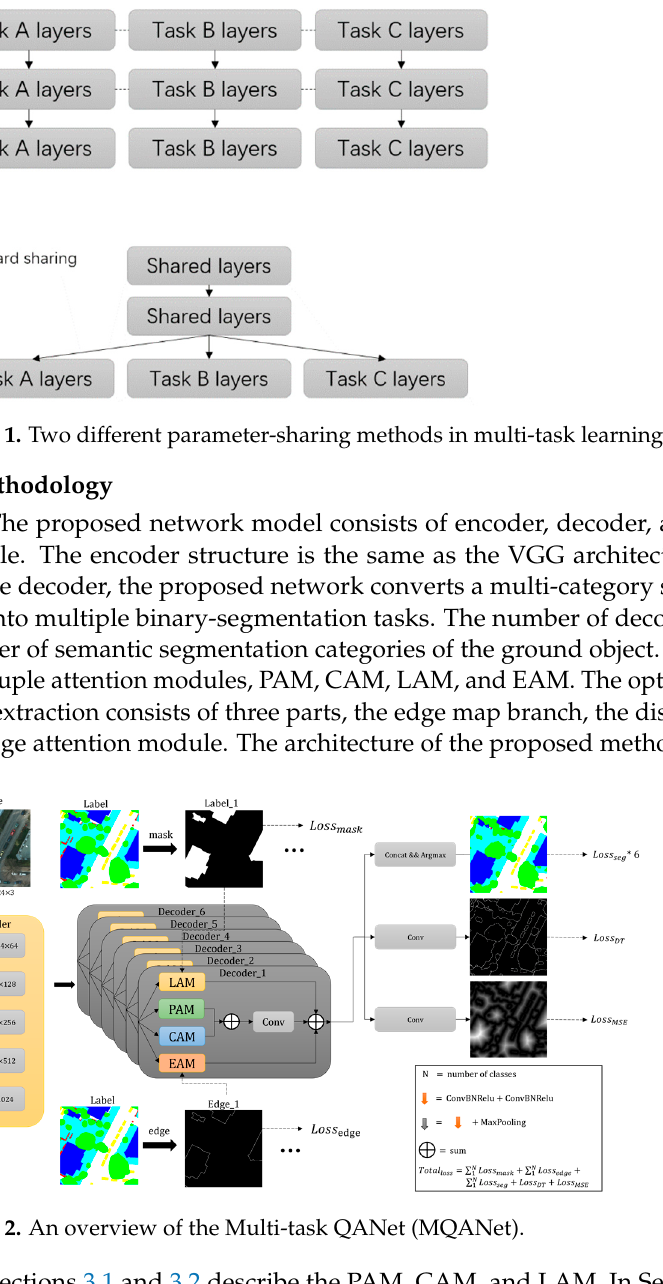
Figure 2. An overview of the Multi-task QANet (MQANet).